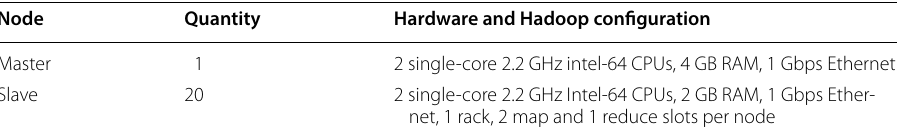
Table 2 Configuration properties of the cluster